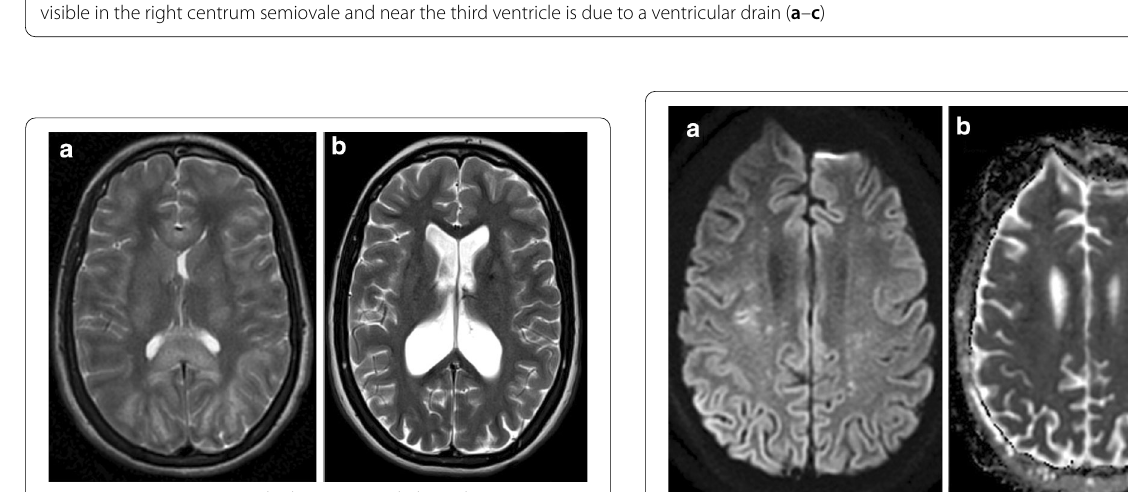
Fig. 5 A case representing the long-term radiological consequences of CFE. T2 MRI images at the level of the basal ganglia of a 16-year-old polytraumatised female patient acquired on day 12 after hospital admission ( a ), and 16 months later ( b ). The long-term follow-up images show resolution of the subcortical and corpus callosum T2 hyperintensities, and dilation of the intergyral sulci, and the lateral ventricles indicative of cerebral atrophy ( b )